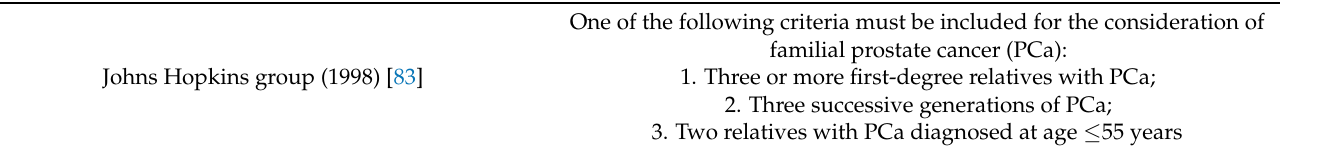
Table 1. Summary of the current guidelines on hereditary prostate